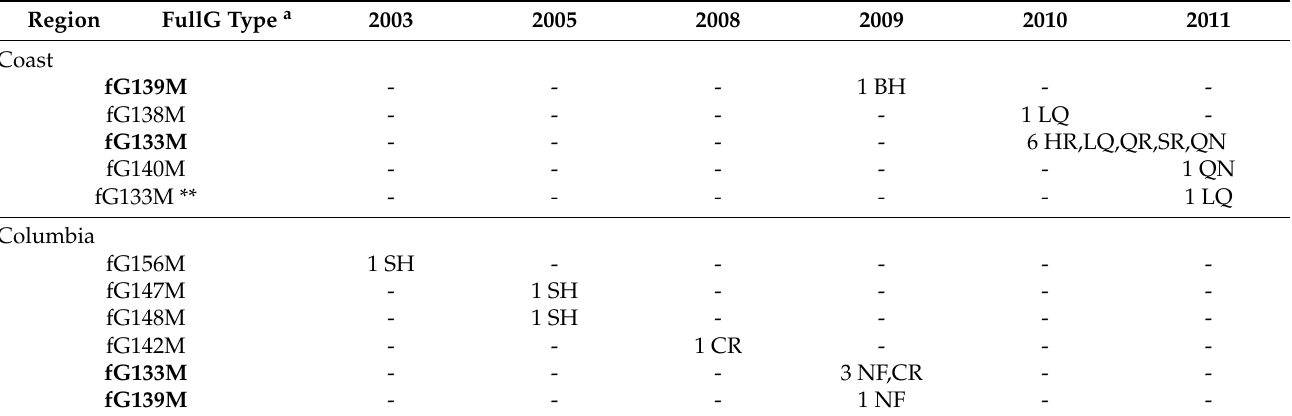
Table 4. Full G genotypes identified in mG139M IHNV isolates from the third MD IHNV emergence event in coastal steelhead. Regional and temporal distribution are shown for mG139M isolates in the coast region during the period 2009–2011 and for candidate source isolates from the Columbia region in preceding and concurrent years. Numbers in columns are numbers of isolates, with locations indicated as shown in Figure 1. Dashes indicate no detection of a given fG genotype in a given